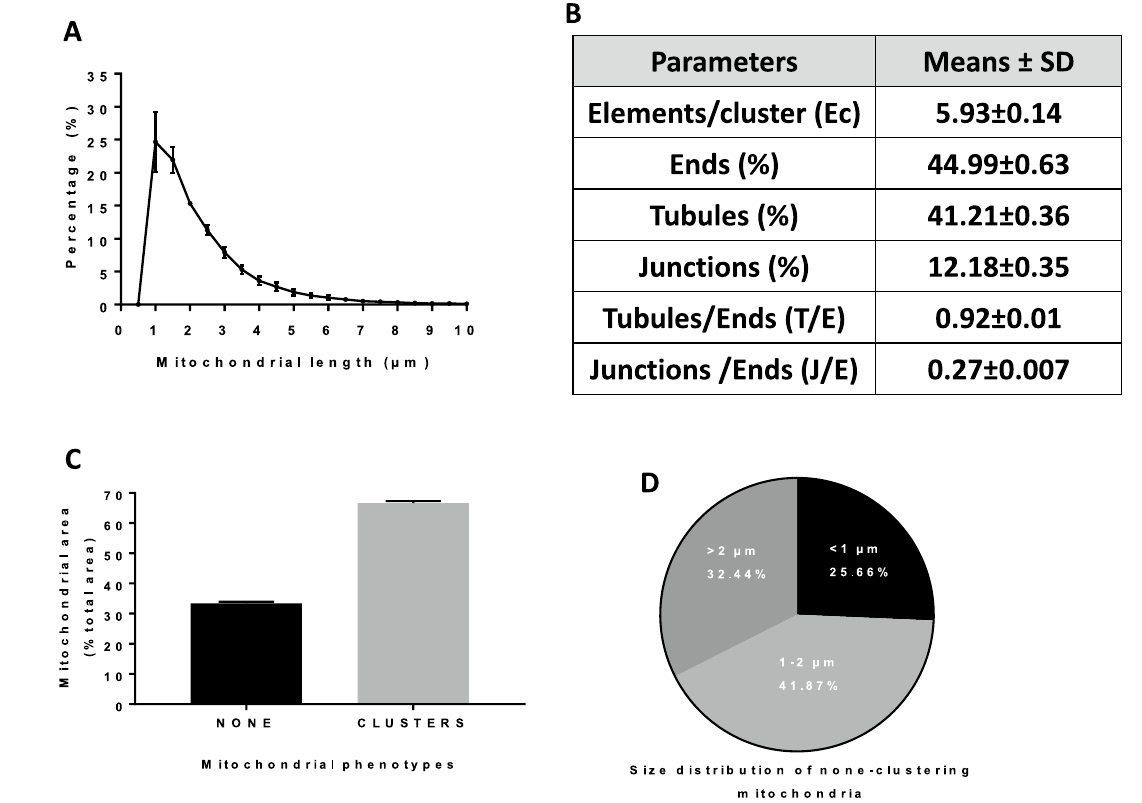
Figure 2. Momito analysis of mitochondrial morphologies in cumulus cells using confocal images. ( A ) Quantification of mitochondrial length distribution. ( B ) Parameters of mitochondrial network. ( C ) Area percentage covered by each mitochondrial phenotype. ( D ) Size distribution of none-clustering mitochondria. (n = 3, mean ±